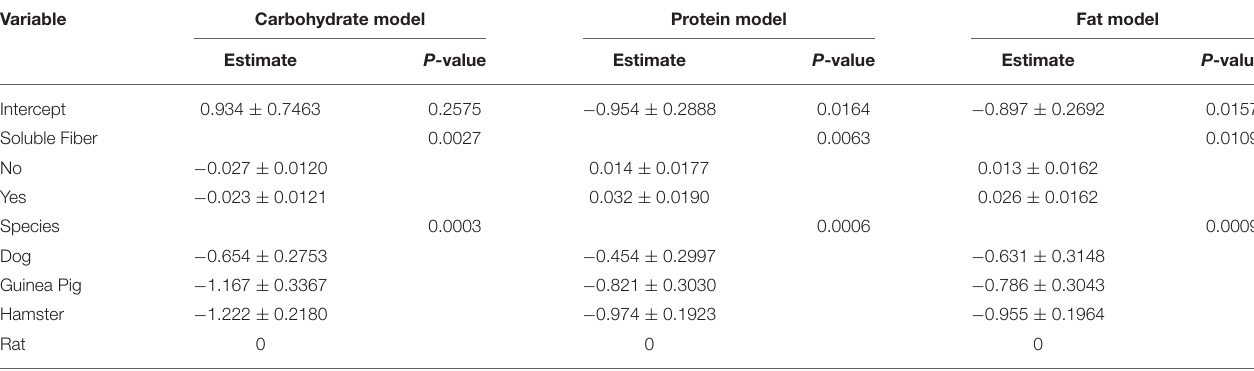
TABLE 4 | Parameters estimates for the model equations developed to estimate total bile acid excretion (lognormal data scale).